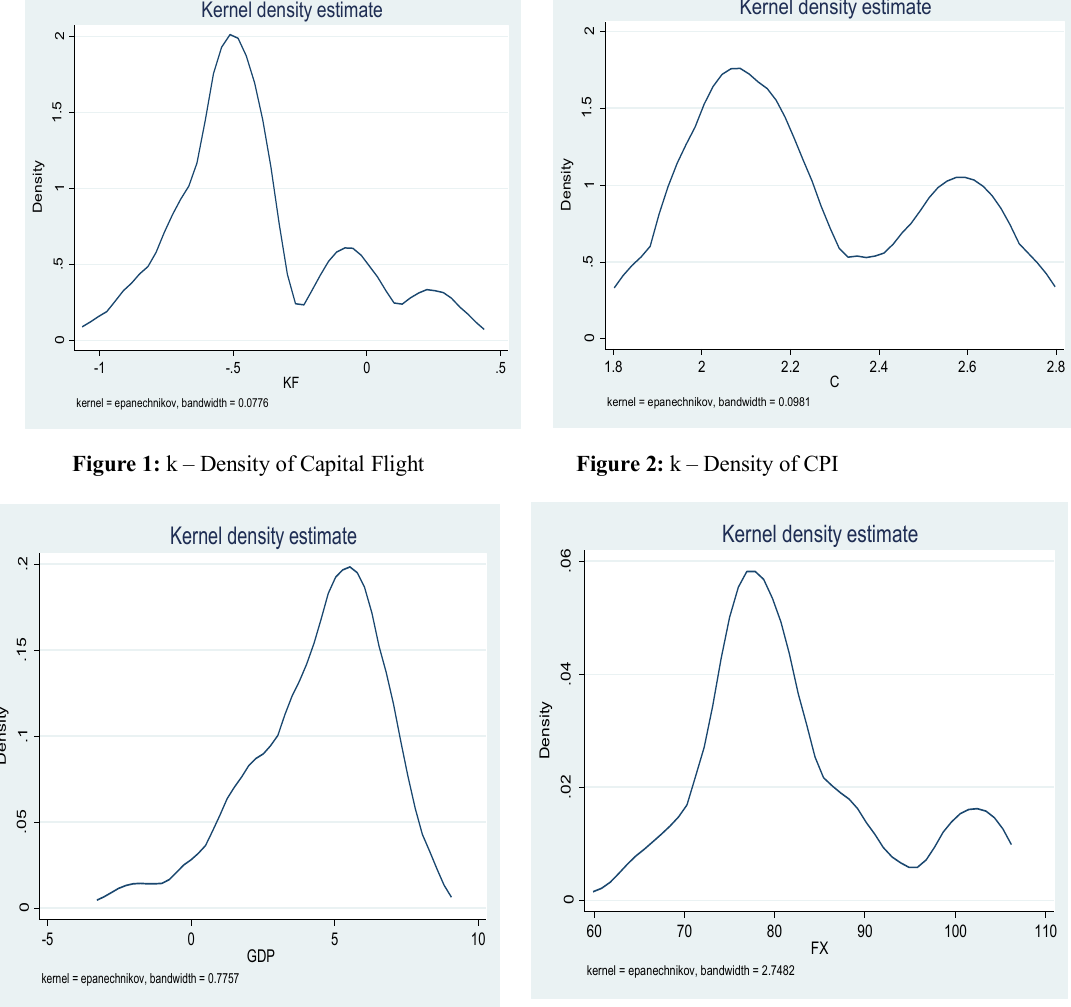
Figure 3: k – Density of GDP growth rate Figure 4: k – Density of Exchange Rate